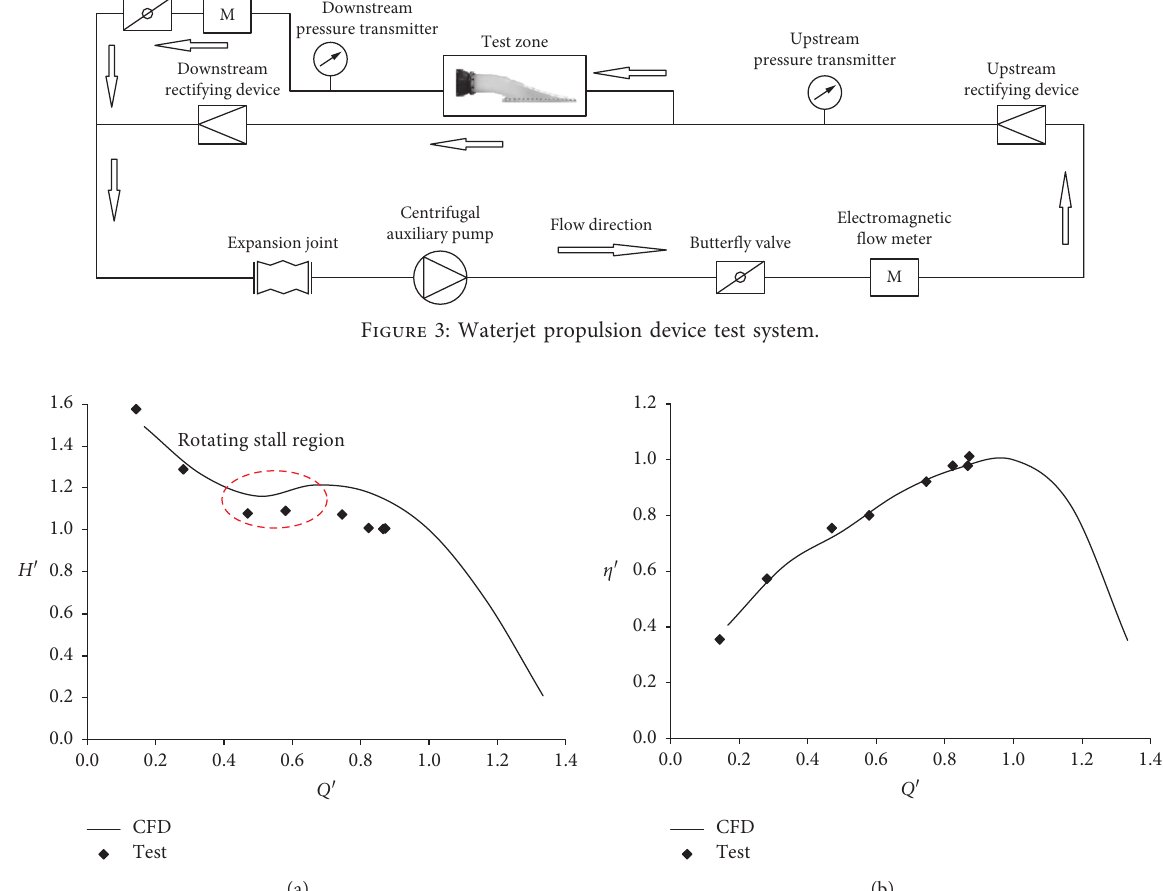
Figure 4: Head and efficiency of CFD and experimental results: (a) Q ′ -H ′ curve; (b) Q ′ -η ′